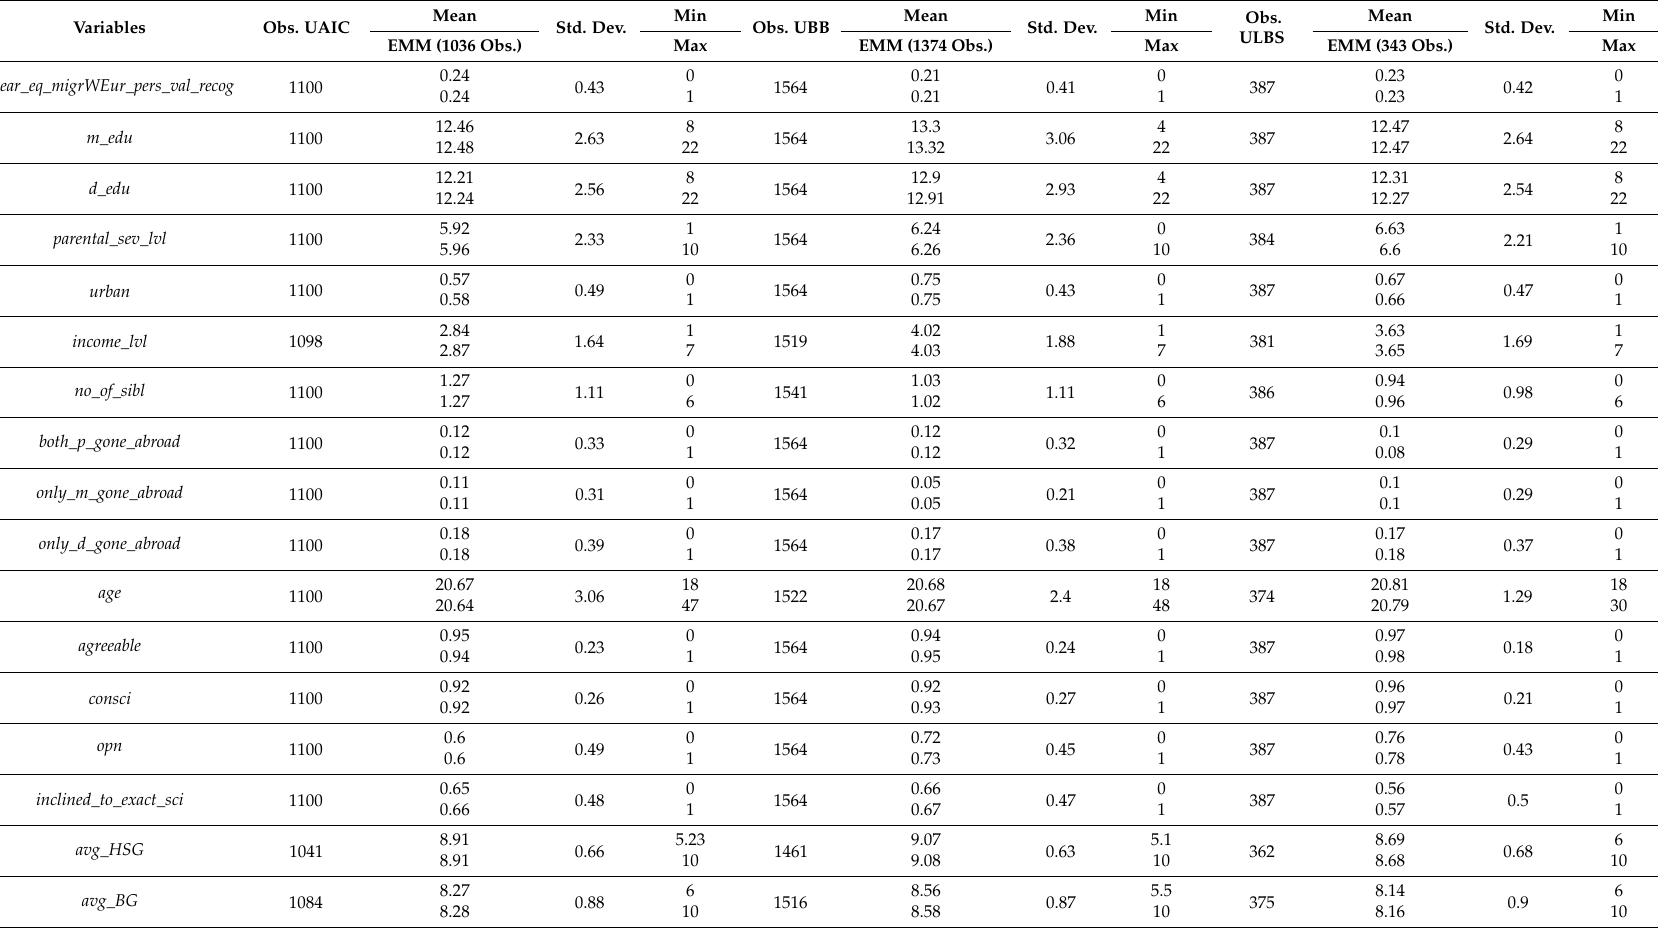
Table 1. Descriptive statistics for all university centres, including the abbreviations of all variables originally considered for the gradual introduction in regressions (three